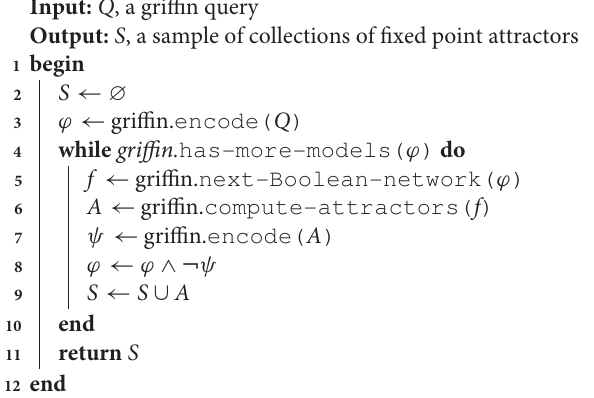
Algorithm 3: Exploration of sets of fixed point